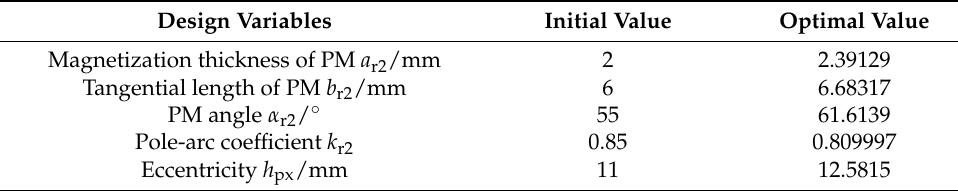
Figure 16. Diagram of the relationship between evolutionary algebra and optimal individual val- ues. Table 6. The constraint scope of the design variable. Table 6. The constraint scope of the design variable.